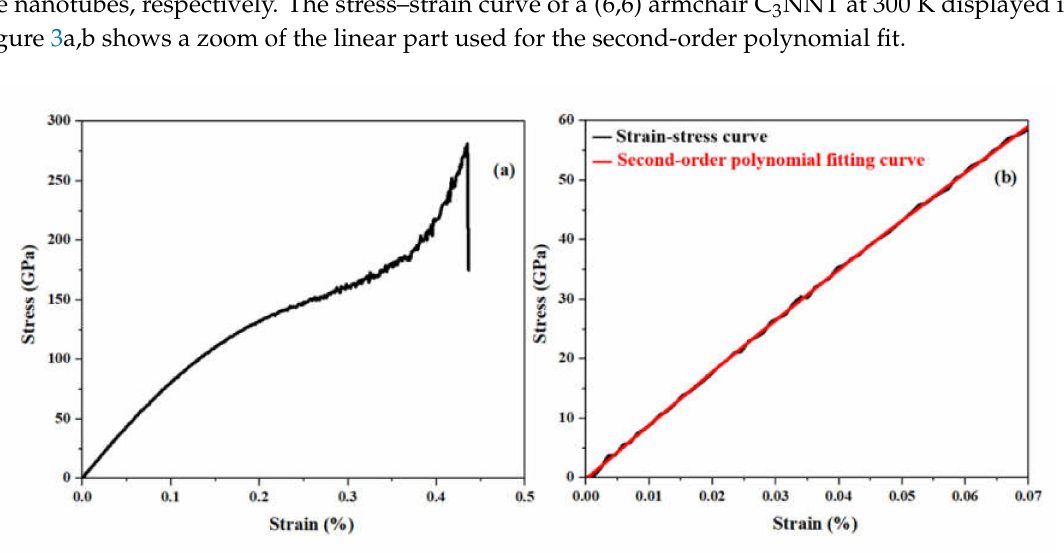
Figure 3. ( a ) Stress–strain curve for a (6,6) armchair C 3 NNT, and ( b ) second-order polynomial fit to the first part of the